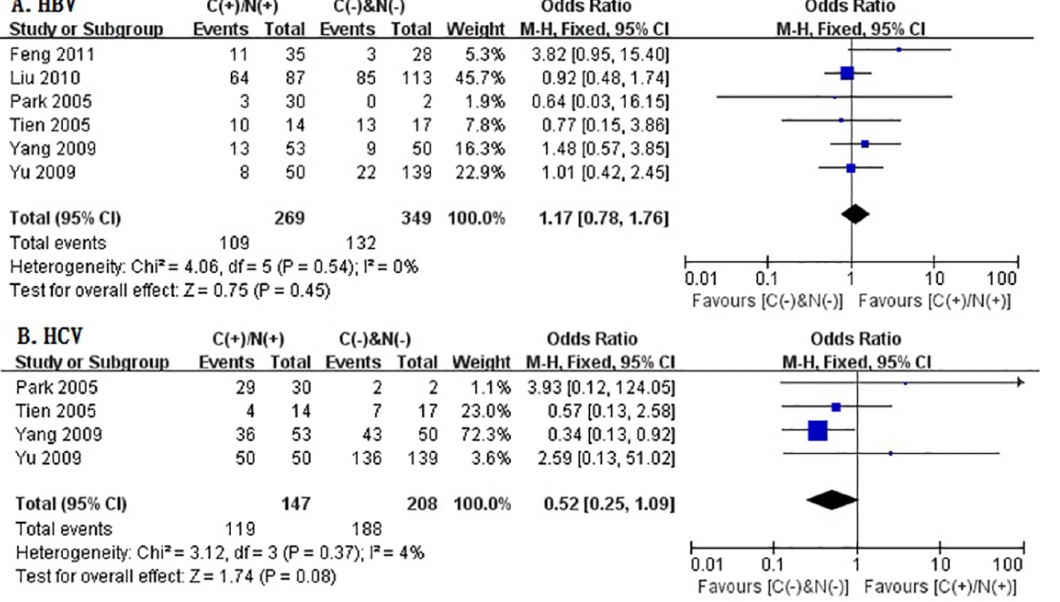
Figure 12. Forest plot of odds ratio for the association of b -catenin expression in cytoplasm and/or nucleus with etiology. A: HBV; B: HCV.